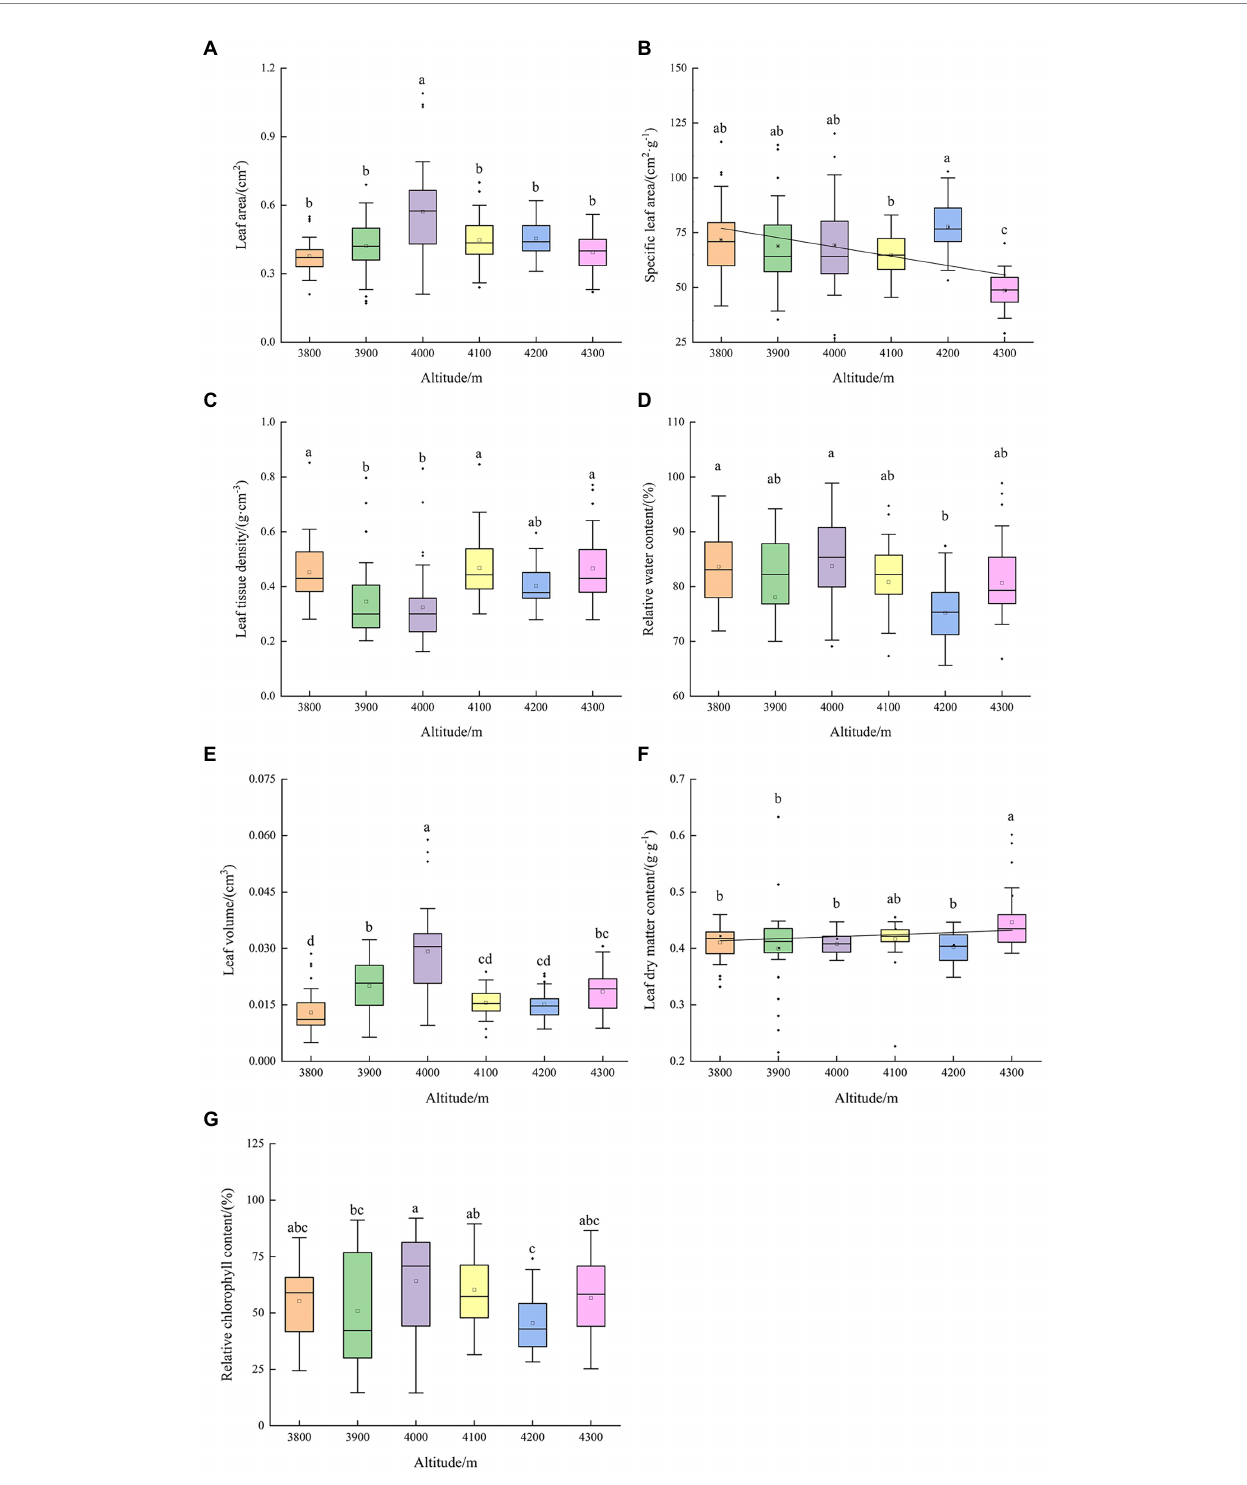
FIGURE 2 Altitudinal distribution of leaf functional traits of Abies georgei var. smithii. in southeast Tibet. (A) Leaf area (LA); (B) Specific leaf area (SLA); (C) Leaf tissue density (LTD); (D) Relative water content (RWC); (E) Leaf volume (LV); (F) Leaf dry matter content (LDMC); (G) Relative chlorophyll content (RCC). Different lowercase letters in the figure indicate significant differences ( p <